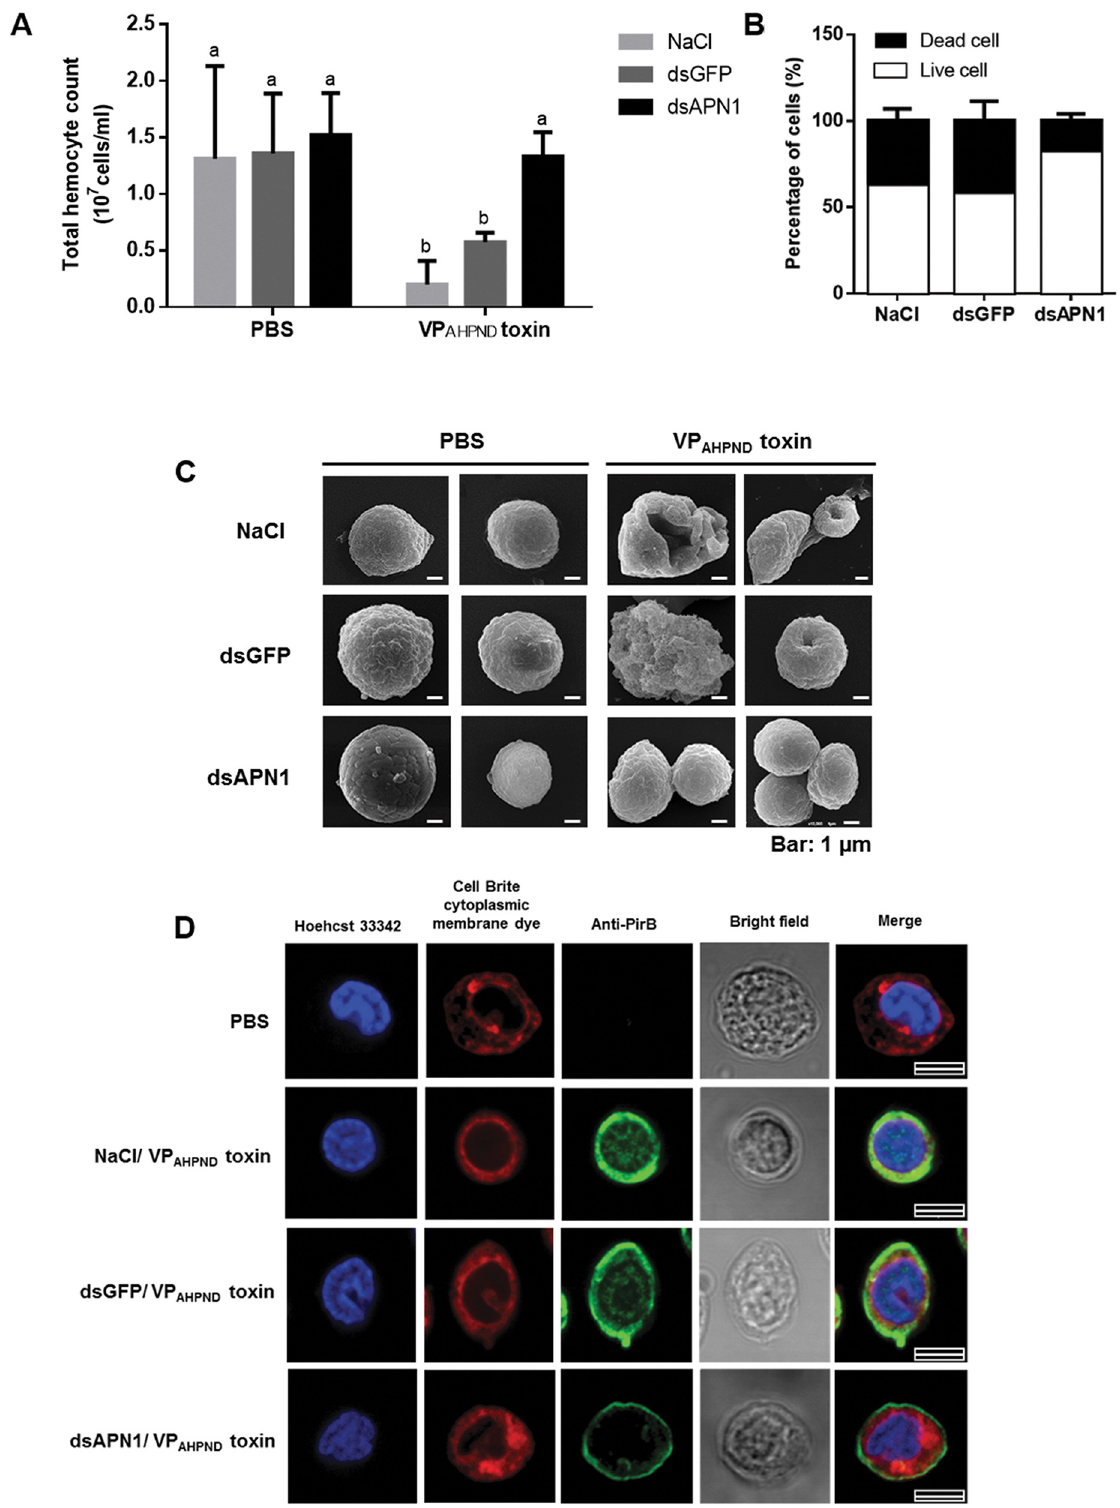
Fig 4. The effect of Lv APN1 silencing on shrimp hemocyte homeostasis. (A) Effect of Lv APN1 silencing on the total hemocyte count after challenge with the partially purified VP AHPND toxins. Experimental groups were the same as those used in Fig 3B. PBS was used as